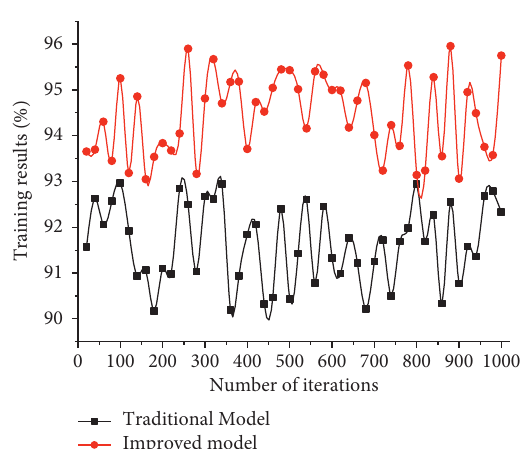
Figure 3: Comparison of models on EMNIST dataset.